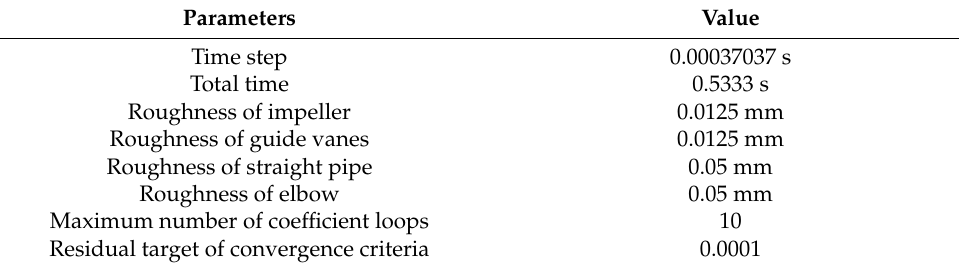
Table 3. Main parameters of boundary condition for transient